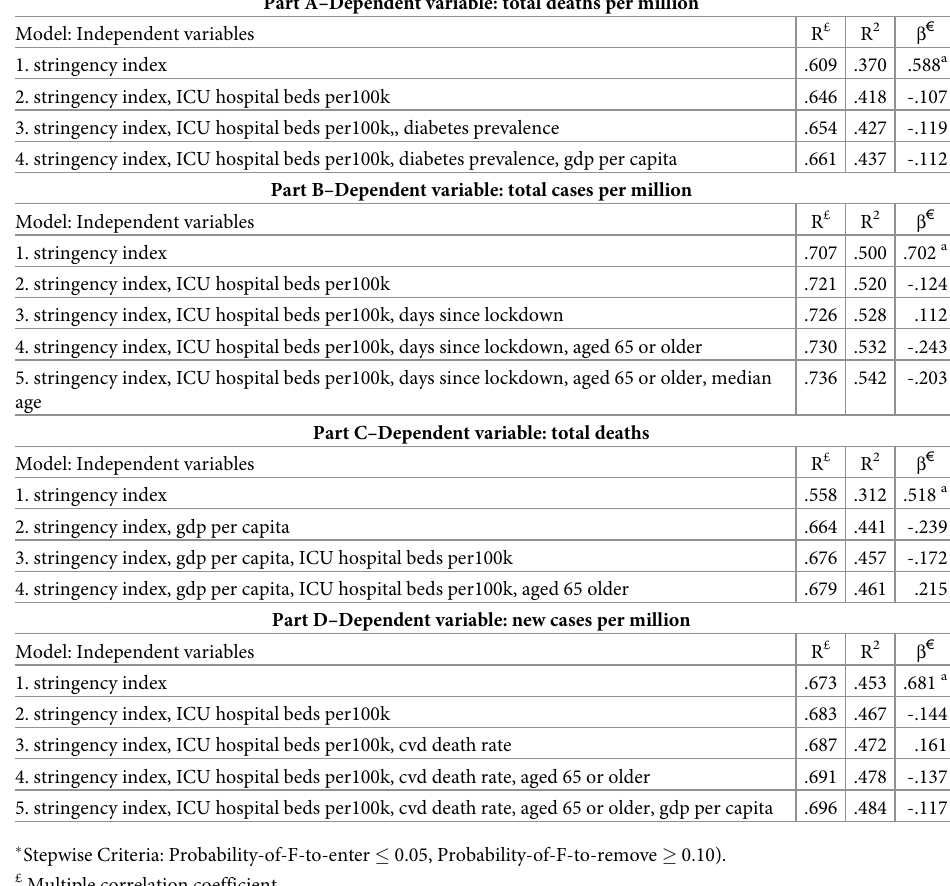
Table 2, Part B has total cases per million with 5 independent variables: stringency index ( β = 0.702, p < .01), ICU hospital beds per100k ( β = -0.124, p < .01), days since lockdown ( β = 0.112, p < .01), aged 65 or older ( β = 0.243, p < .01), and median age ( β = -0.203, p < .01). This model results in a multiple R = 0.736 and R 2 = 0.542 (54.1% of the variance). The regres- sion analysis for total deaths (independent variable) is summarized in Part C of Table 2. The optimal model consists of stringency index ( β = 0.518, p < .01), gdp per capita ( β = -0.239, p < .01), ICU hospital beds per100k ( β = -0.172, p < .01), and aged 65 or older ( β = 0.215, p < .01). This model results in a Multiple R = 0.679 and R 2 = 0.461 (i.e., 46.1% of the variance).